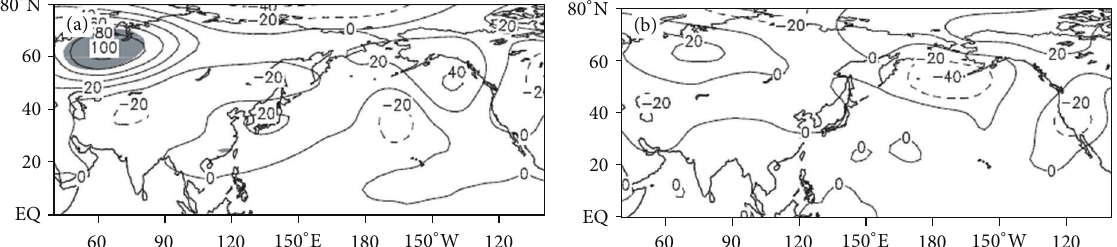
Figure 11: Composite 500hPa level geopotential height for flooding spring years (a) draught spring years (b) in in South China (unit: gpm).